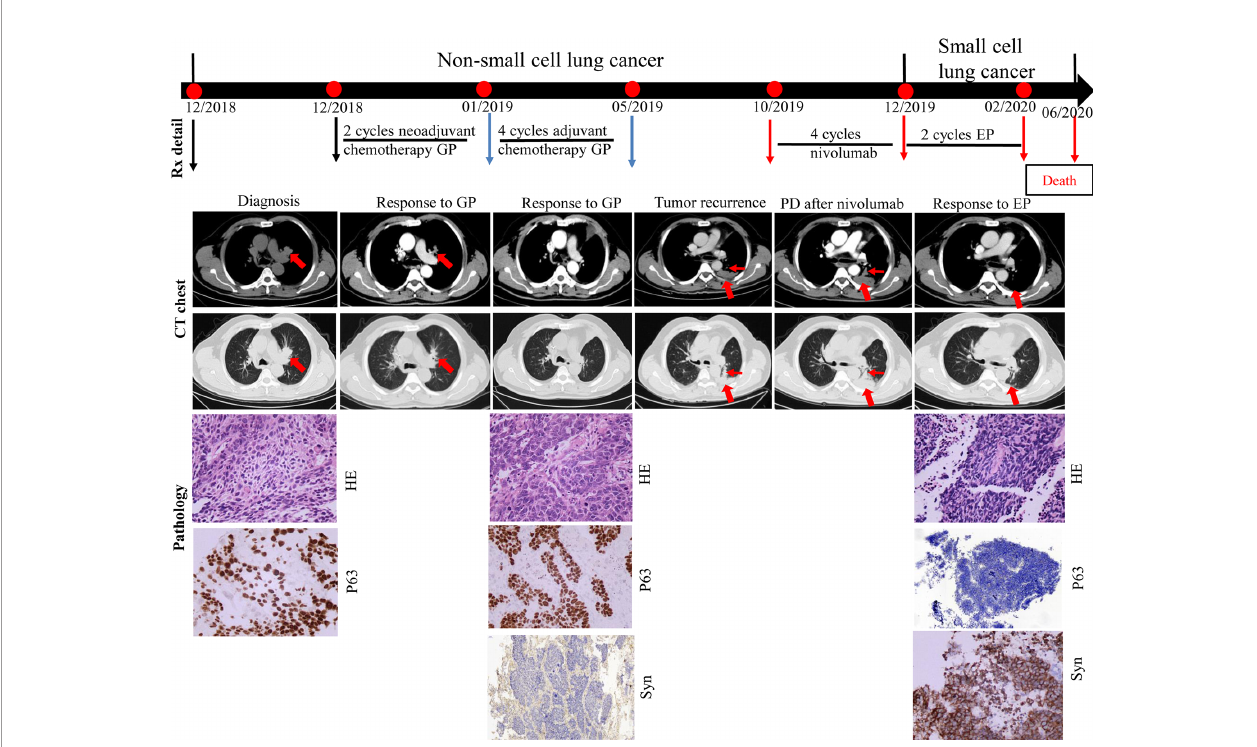
FIGURE 2 | Case presentation of transformation of lung squamous cell carcinomas to small cell lung carcinoma with nivolumab. CT, computed tomography; HE, Hematoxylin and Eosin; IHC, immunohistochemical; G, gemcitabine; P, cisplatin; E, etoposide; Syn, synaptophysin; Rx,